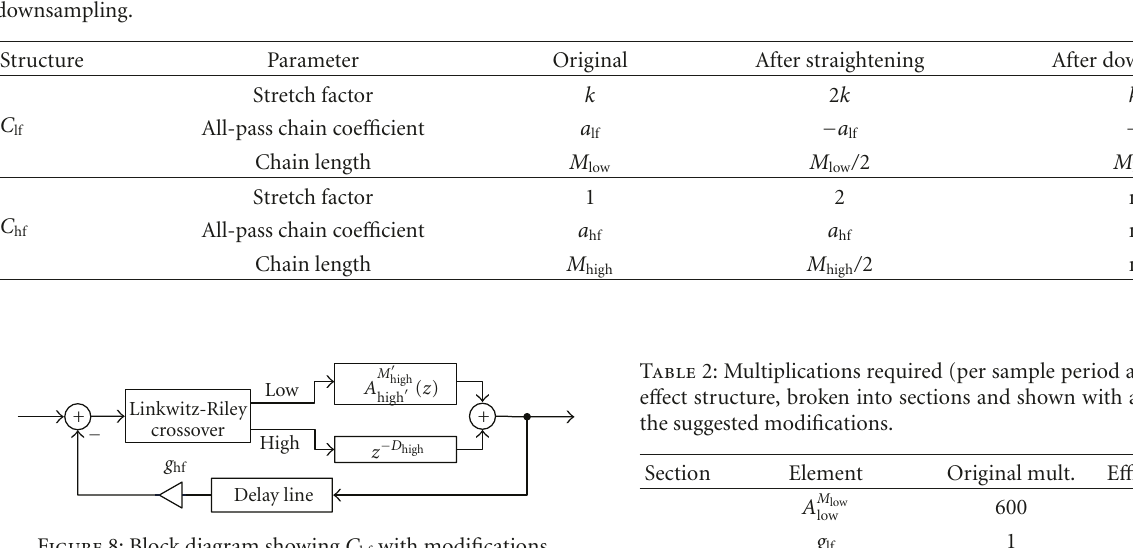
Figure 8: Block diagram showing C hf with modifications.